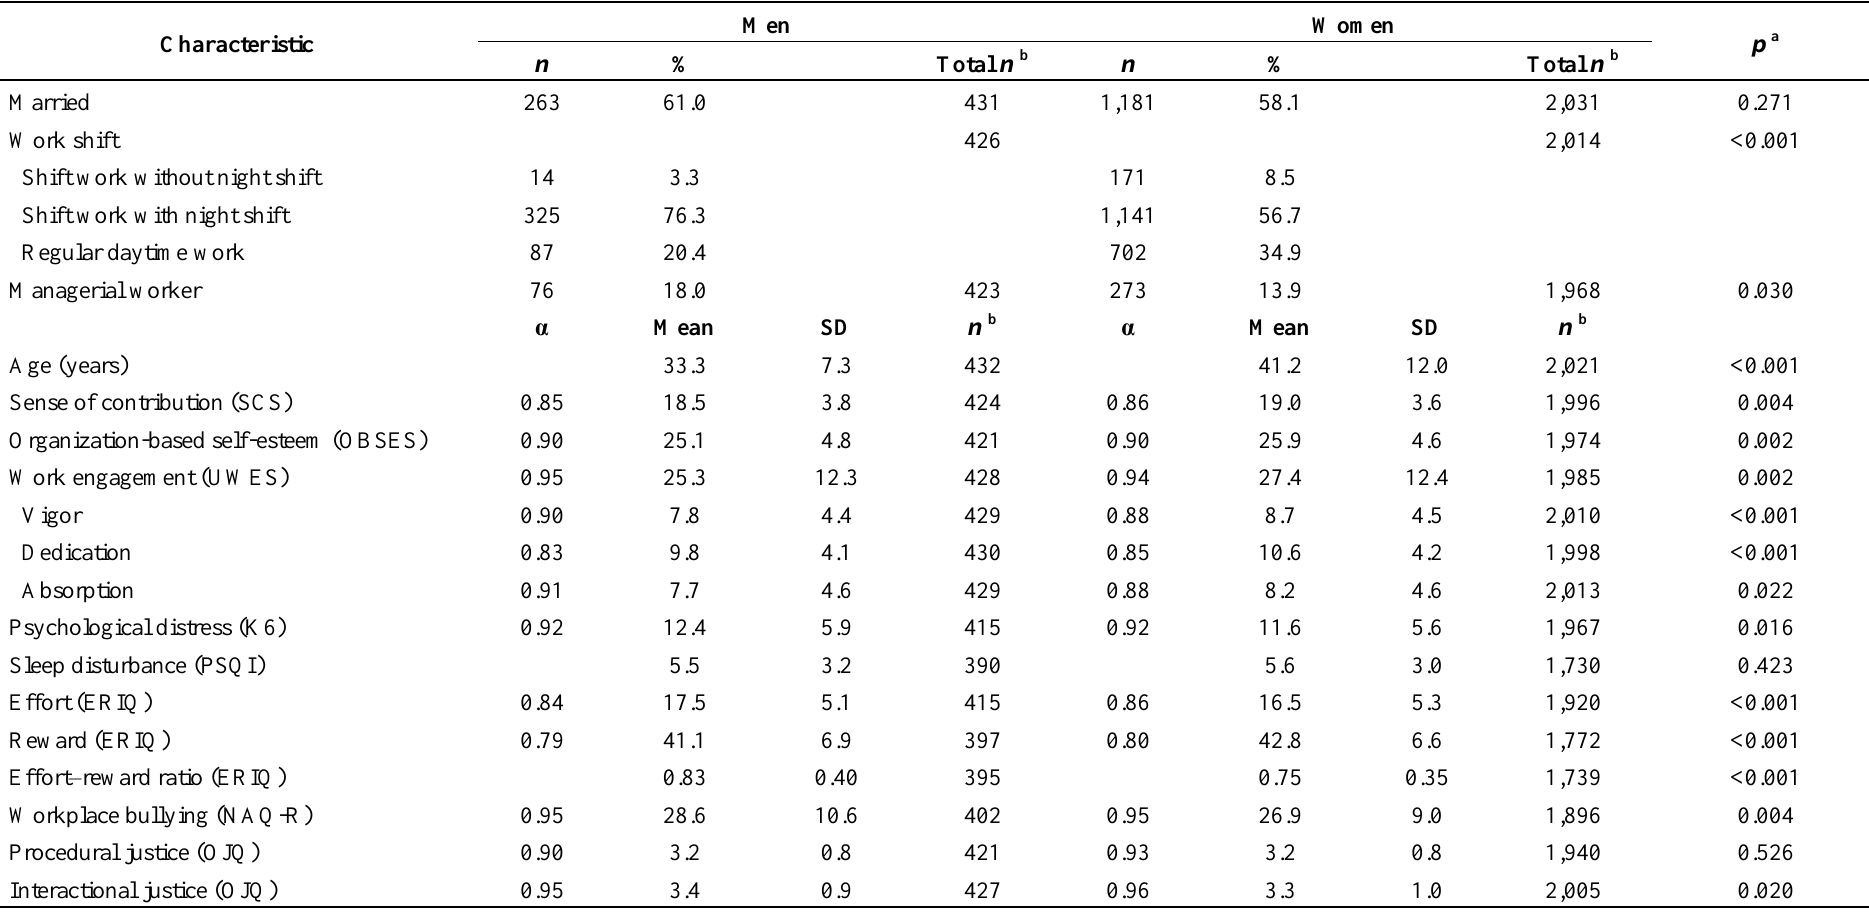
Table 1. Participant characteristics according to gender.